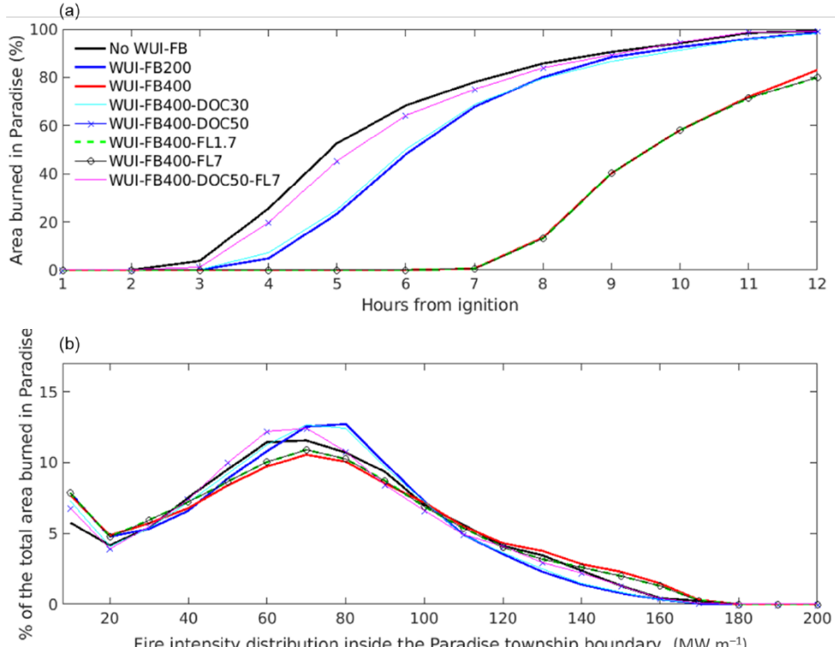
Figure 7. Plots showing ( a ) time vs. total area burned in Paradise (inside the magenta polygon in Figure 1) and ( b ) fire intensity distribution for the 2018 Camp Fire simulations. Refer to Table 2 for the experimental settings for each simulation name.